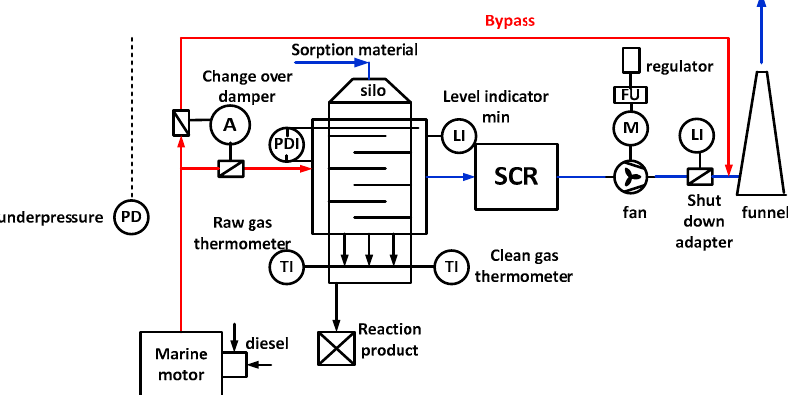
Figure 6. Schematic view of a dry exhaust gas treatment system for SO x reduction and a SCR unit for NO x mitigation. (Figure was genuinely generated using data from ref. [30]).